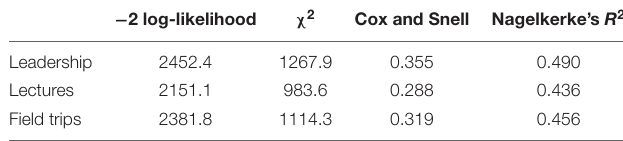
TABLE 2 | Model fit values for leadership